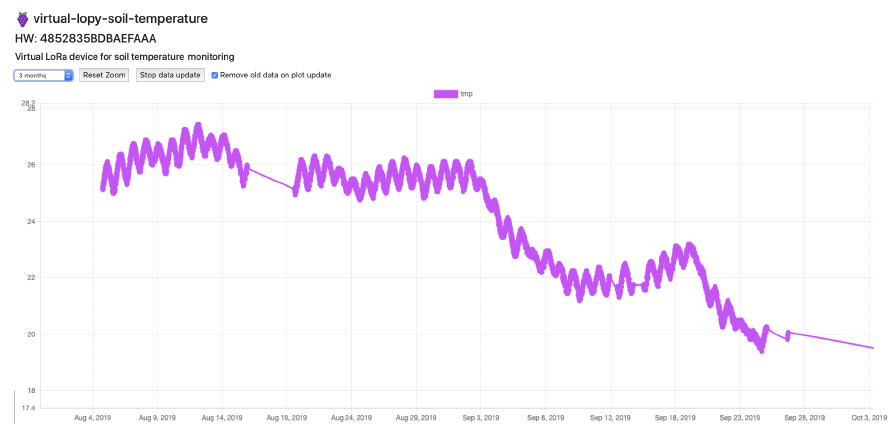
Figure 12. The developed dashboard: soil temperature values collected during 3 months of test by the SN-V2 of the vineyard